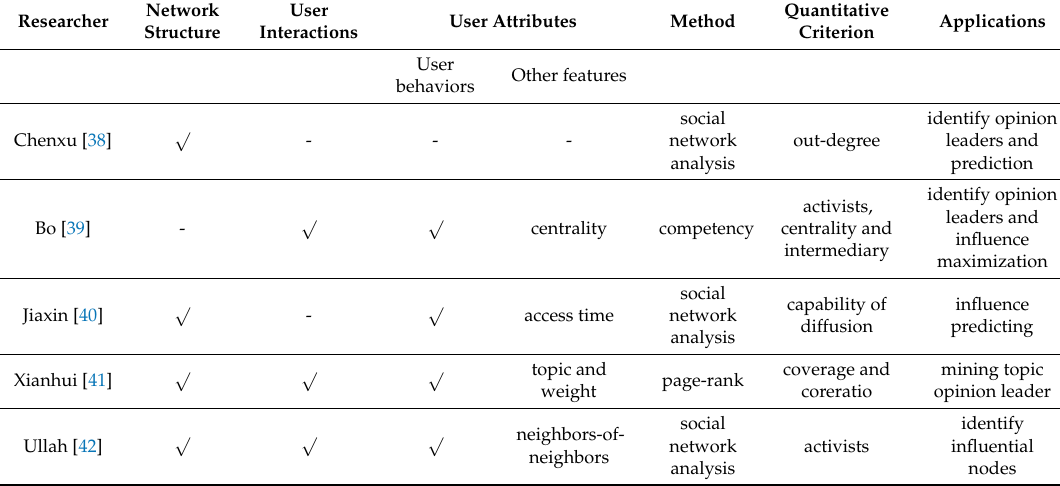
Table 2. Comparison of the Individual Influence